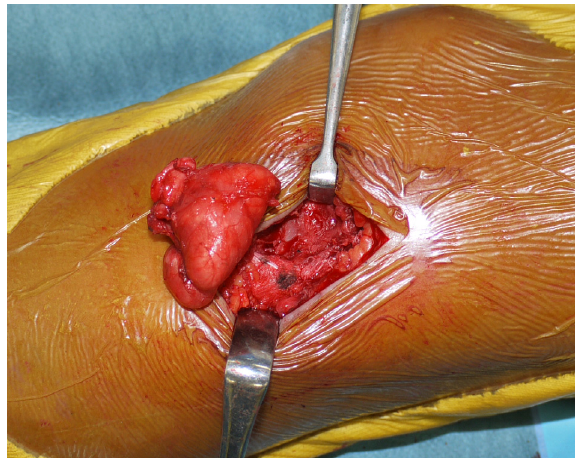
Figure 3. Resection of the tumor. The tumor was a yellow soft mass with a thin capsule. The tumor was found under the iliotibial tract and was not in contact with the knee